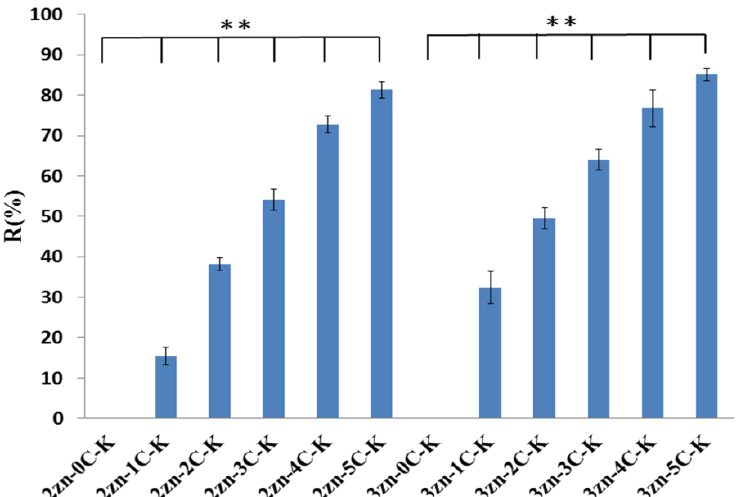
Figure 9. Antibacterial rate of functional antibacterial knitted fabrics as related to twist coefficient. Note: data shown as mean standard deviation (SD) ( n = 3). ** p < 0.01.